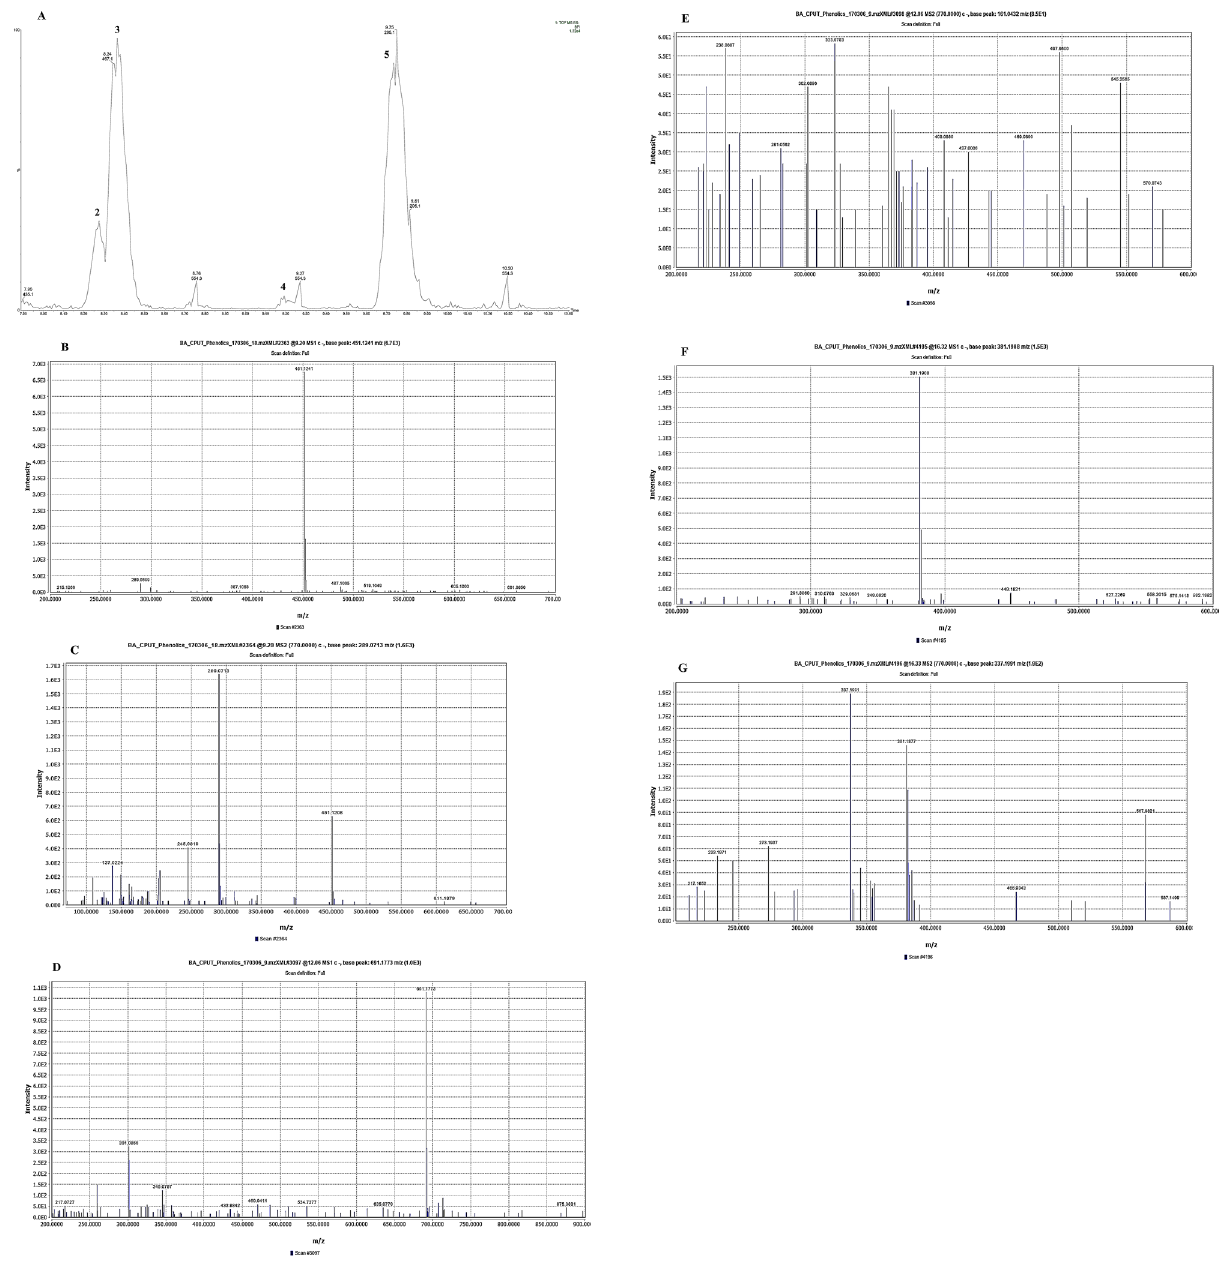
Figure 2. Phytochemicals and mass spectra of identified flavonoids and phenolic acids in Bambara groundnut samples. ( A ) chromatogram of identified compounds; ( B ) unfragmented spectra MS1 of compound 4 (m/z 451 and Rt, 9.20); ( C ) fragmentation spectra MS2 of compound 4 in negative (ESI−) mode; ( D ) unfragmented MS1 spectra of compound 10 (m/z 691 and Rt, 12.06); ( E ) fragmentation spectra MS2 of compound 10 in negative (ESI−) mode; ( F ) unfragmented MS1 spectra of compound 13 (m/z 381 and Rt, 16.32); ( G ) fragmentation spectra MS2 of compound 13 in negative (ESI−) seen to possess a higher phenolic acid concentration 56 . Ojwang et al. 55 postulated that flavonoids are largely concentrated in the seed coat of pulses, with their effect on the colour of the seed coat of great influence on their choice and use in different food applications. Consumption of pulses due to the availability of bioactive compounds have been implicated for the reduction of cardiovascular disease risk factors 57 . Furthermore, a diet rich in pulses provides a significant amount of phenolic acids, carotenoids and tocopherols that acts as a shield for low-density lipoprotein cholesterol against free radical oxidation 57 .